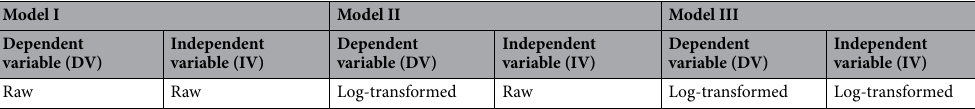
Table 4. The input variables for the three regression models.